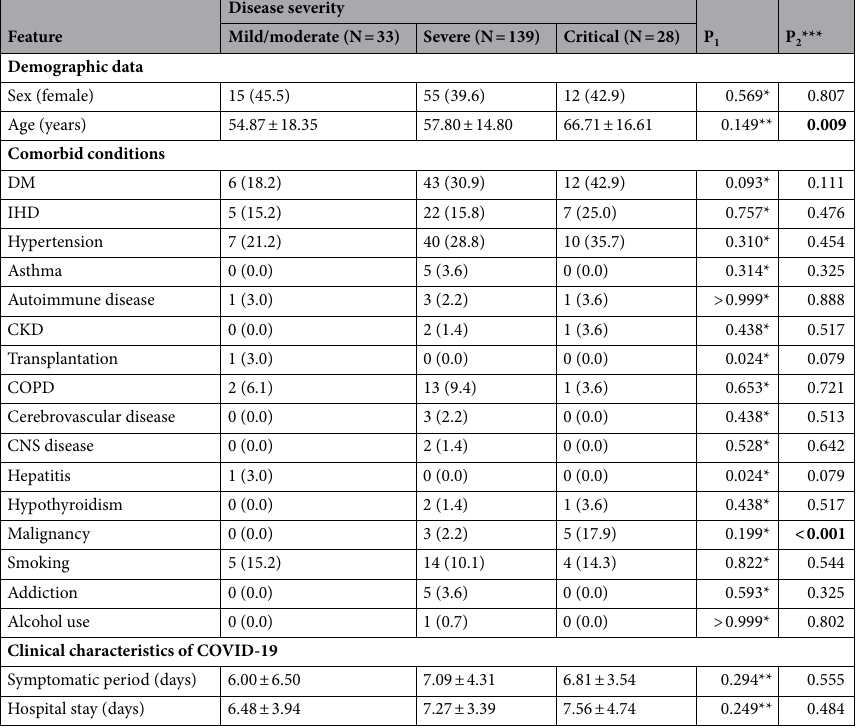
Table 1. Demographic data and comorbid conditions in patients with different disease severities. DM diabetes mellitus, IHD ischemic heart disease, CKD chronic kidney disease, COPD chronic obstructive pulmonary disease, CNS central nervous system. P 1 : Comparison between mild/moderate and severe/critical groups. P 2 : Comparison between mild/moderate, severe, and critical groups. Bold values are statistically significant (P < 0.05). *Chi-square or Fisher’s exact test. **Mann–Whitney test. ***Kruskal–Wallis